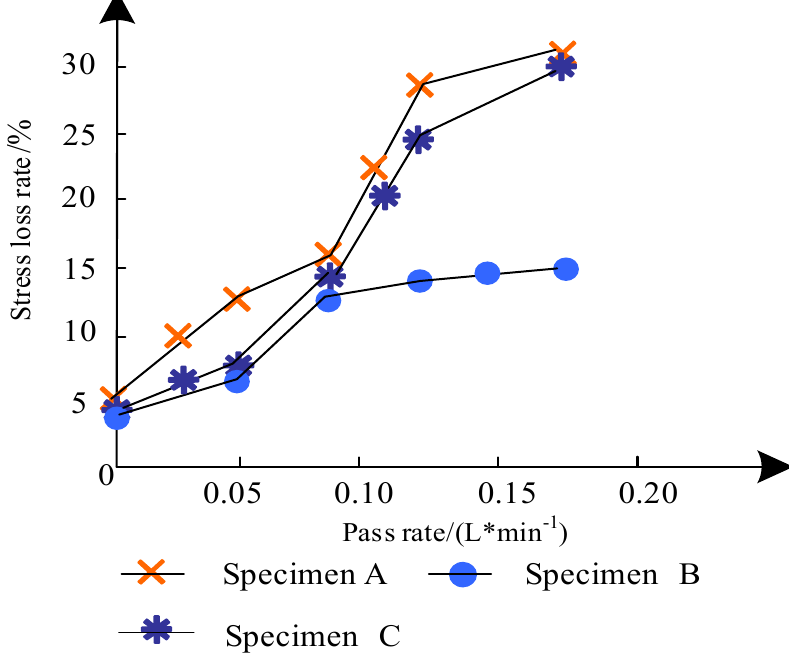
Figure 10. Change rule of stress loss of specimens under different oxygen flow rates.